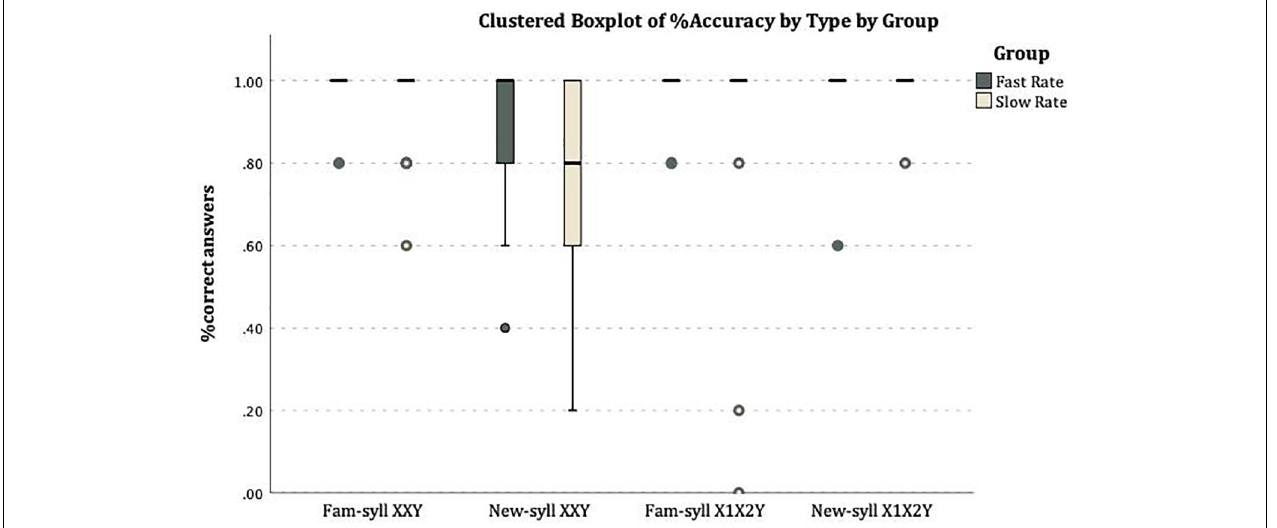
FIGURE 3 | On the X -axis the four types of test items: Familiar-Syllable XXY, New-syllable XXY, Familiar-syllable X1X2Y, New-syllable X1X2Y. On the Y -axis the mean rate of correct answers: correct acceptance for XXY strings (with familiar or new syllables) and correct rejections of X1X2Y (with familiar or new syllables).